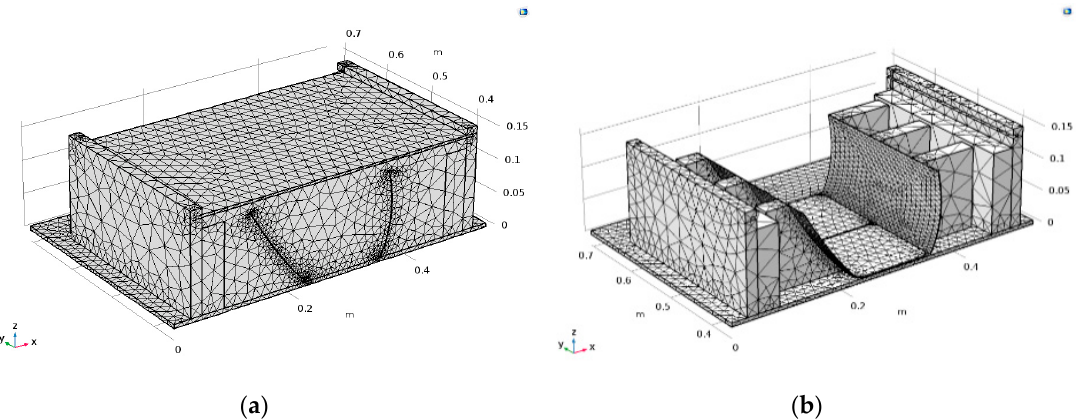
Figure 9. Final mesh adopted for each configuration of the CPC model: ( a ) covered; ( b ) uncovered.